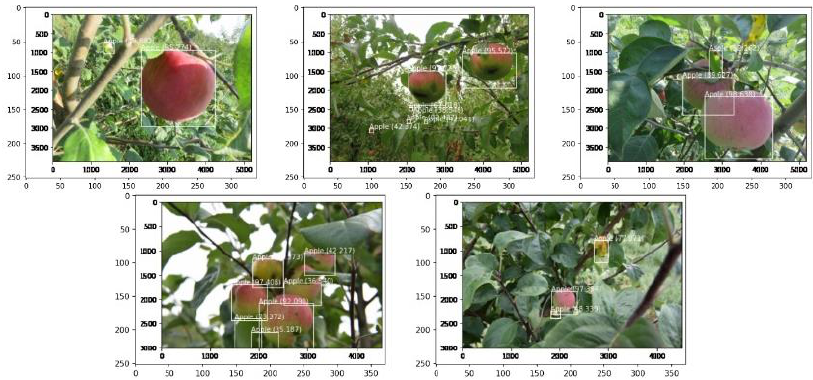
Figure 6. Examples of yellow leaves and gaps between leaves mistaken for apples.